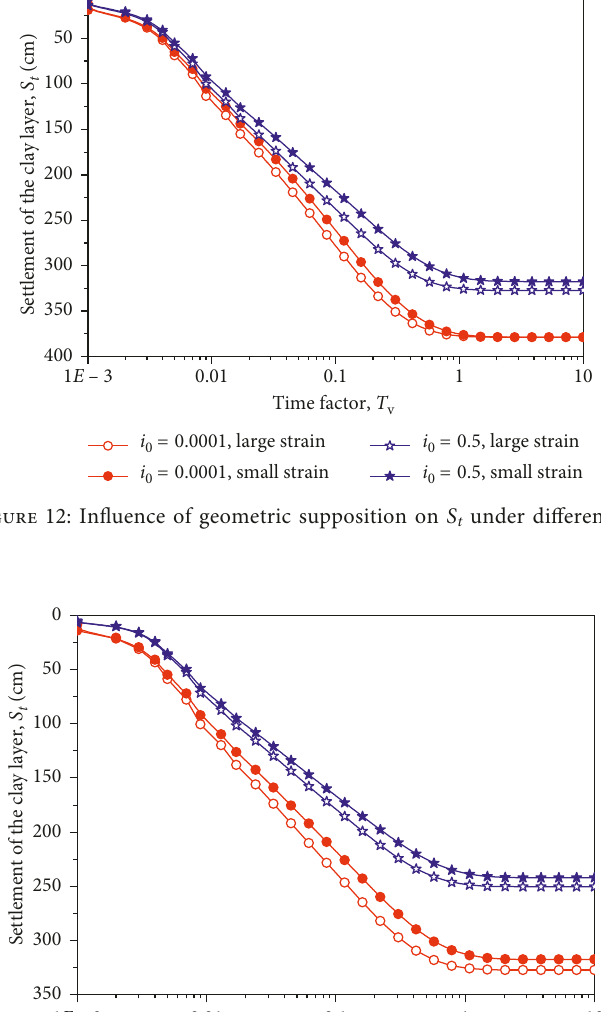
t under different preconsolidation